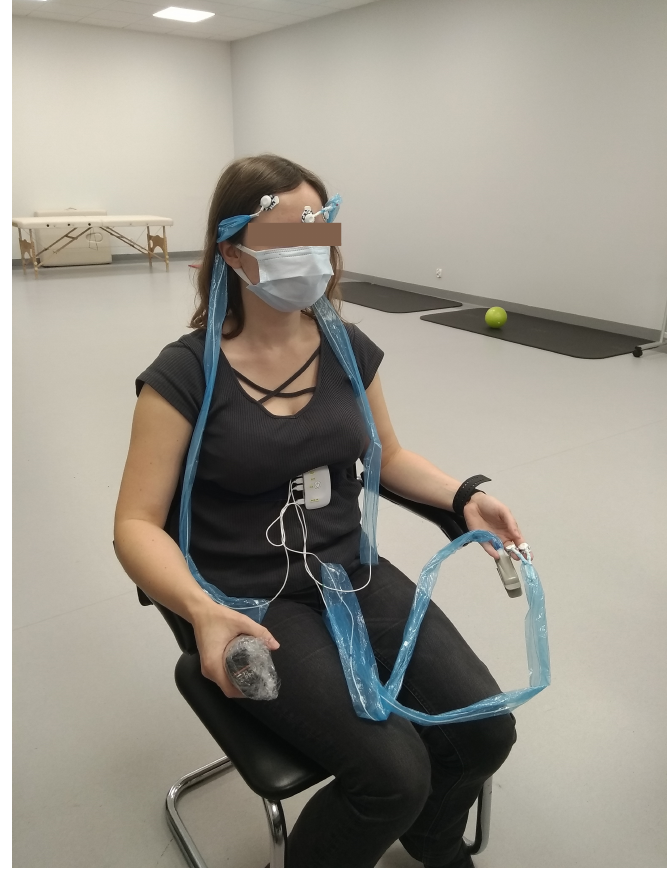
Figure 1. Device